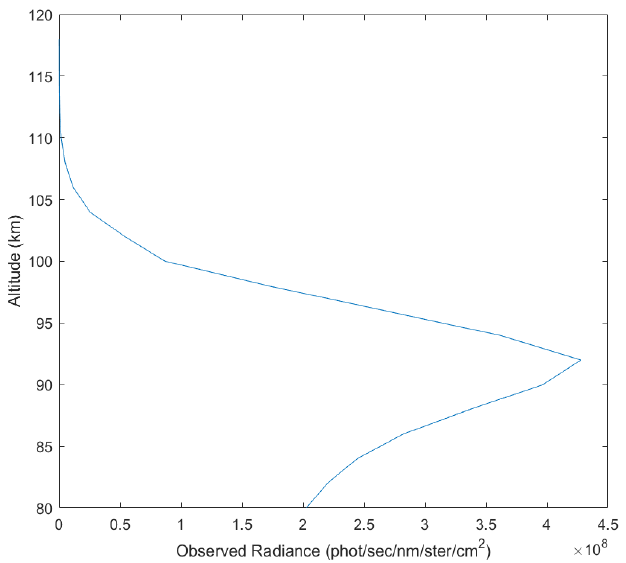
Figure 8. Limb observed radiance vertical profiles of O 2 A -band night glow with random noise.